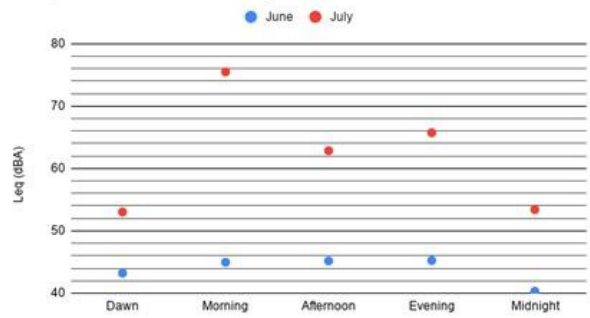
Figure A3: Comparison of the day history of the averaged noise lev- els from June measurements (blue) and July–August measurements